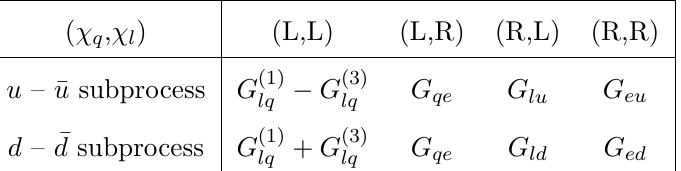
Table 6 . Explicit expressions for the new physics coefficients K 0 generic quark-lepton operators in the Warsaw basis (table 1).